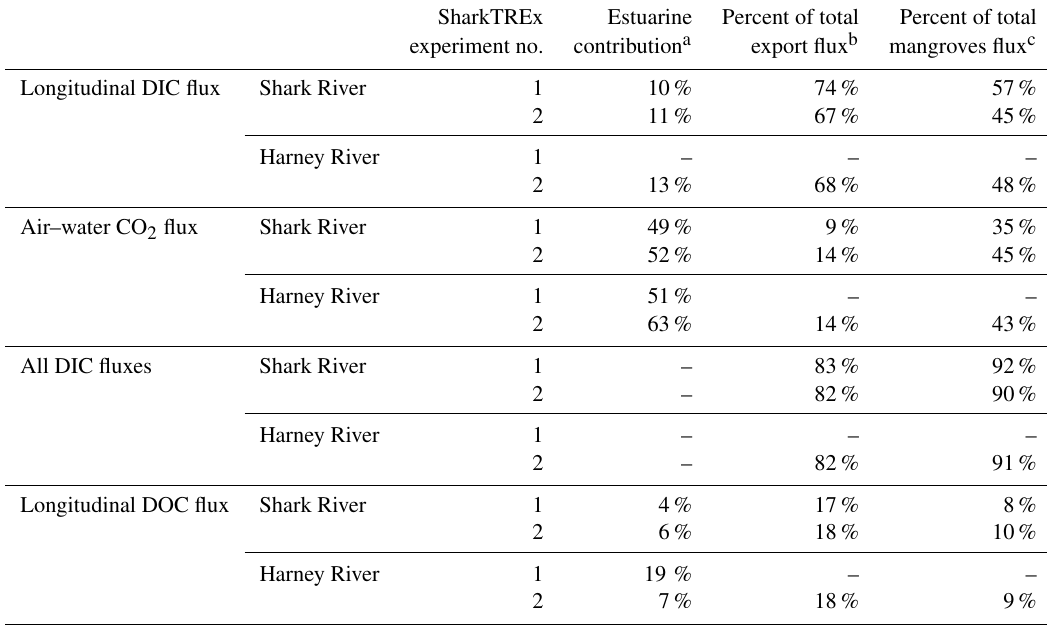
Table 4. Distribution of total and mangrove fluxes of DIC and DOC for Shark and Harney rivers during SharkTREx 1 and